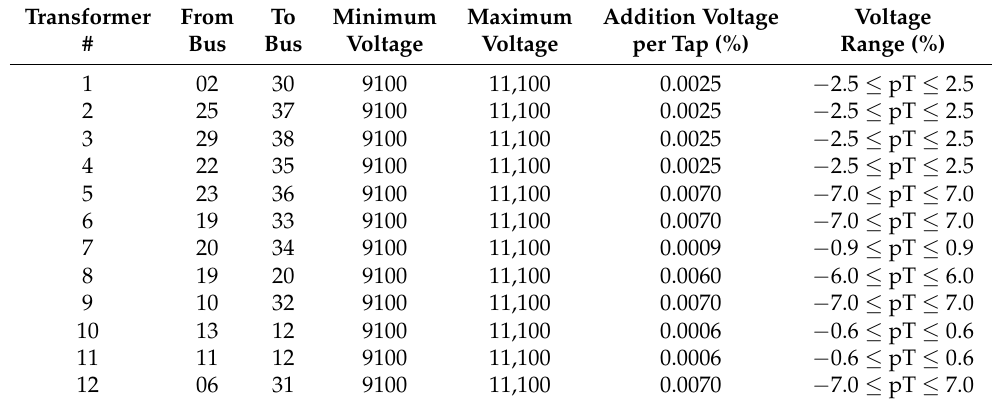
Table 7. Characterization of the transformers in the IEEE 39-bus test system.